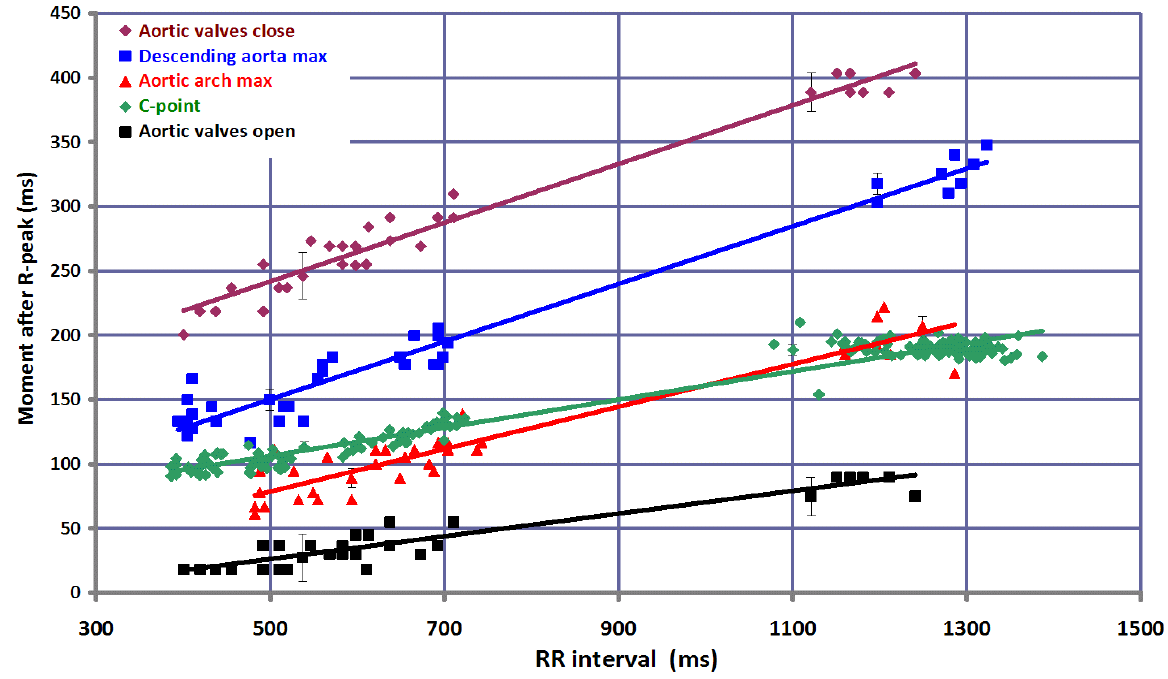
Figure 4: Typical example of results from a subject: the moments of occurrence for each heart cycle marker are presented at various RR-intervals. Shown are from bottom to top: opening aortic valves, C-point ICG, maximum diameter aortic arch, maximum diameter descending aorta and closing aortic valves. Least squares linear regression was used to fit the data. All coefficients of correlation were r > 0.97 (p<0.005). The error bars of C-point indicate the standard deviation at a constant heart rate. For all other markers, the error bars indicate the measurement’s time